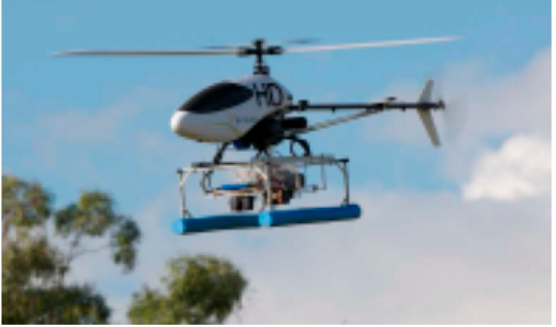
Figure 4. The CSIRO autonomous helicopter system. Adapted from Merz & Chapman, 2012 [113].